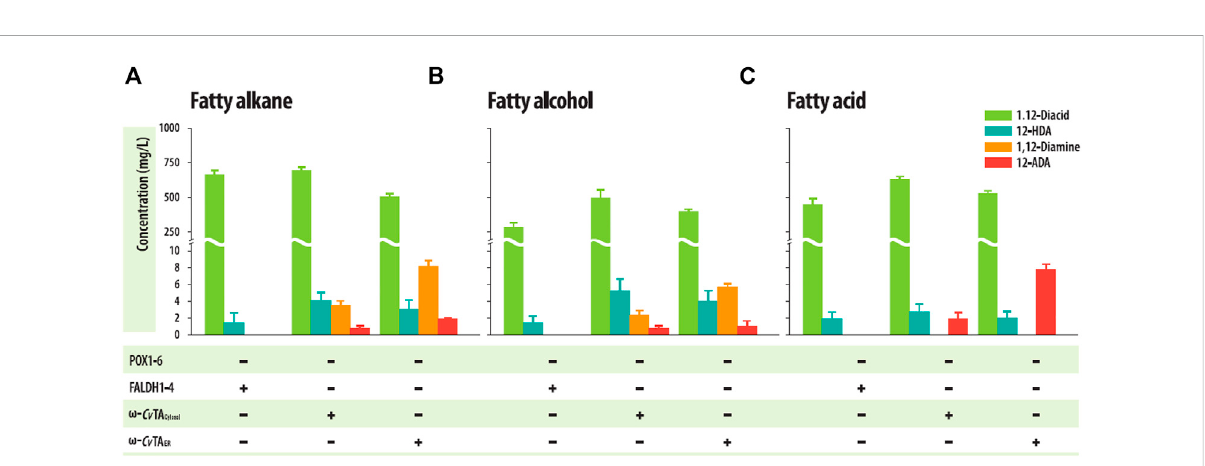
FIGURE 5 Production of α , ω -diaminododecaneand ω -aminododecanoicacidfrom (A) dodecane, (B) dodecanol,and (C) dodecanoicacidbyengineered Y. lipolytica strains in shake fl ask cultures. Error bars represent the standard error of the mean of at least three independent